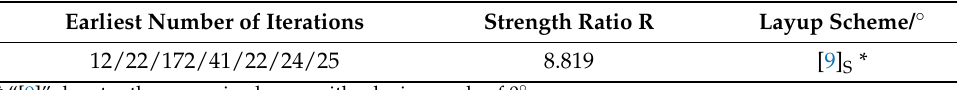
Table 5. Calculation results of traditional genetic